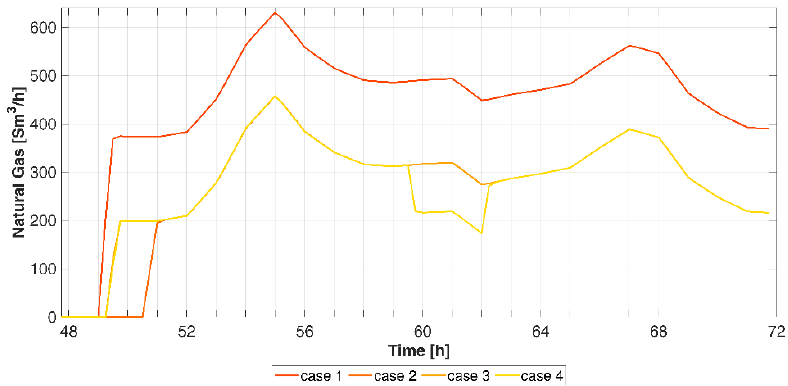
Figure 11. Restoration of inlet natural gas flow at the city-gate reduction station after the 48 h of “linepacking” during the weekend. The gas withdrawal profile depends on the control strategies on the pressure set point and the remodulation of the biomethane injection.